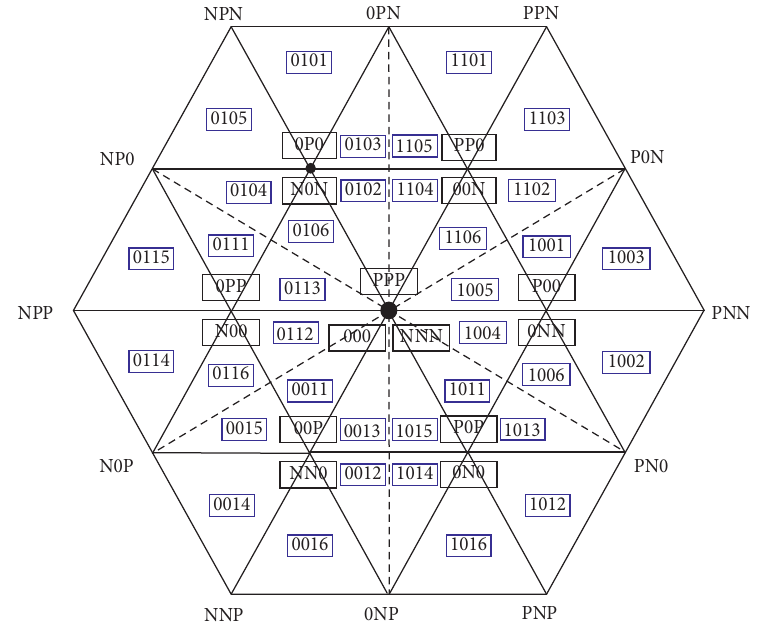
Figure 5: An index diagram from auxiliary integer values to the location of point (u